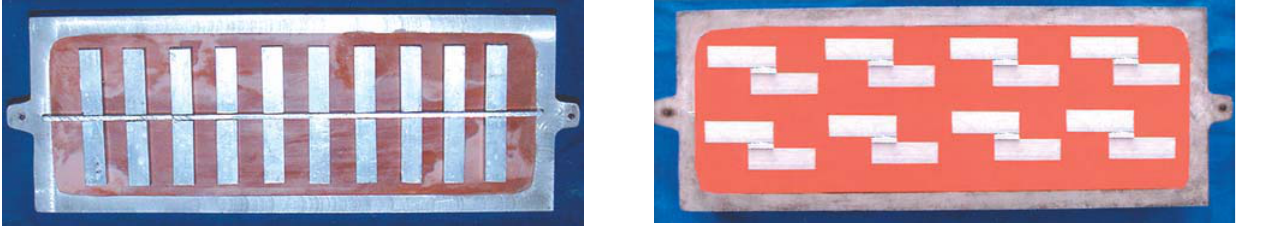
FIGURE 1- Aluminum bars and spacer in the mold used for fabrication of tensile strength specimens